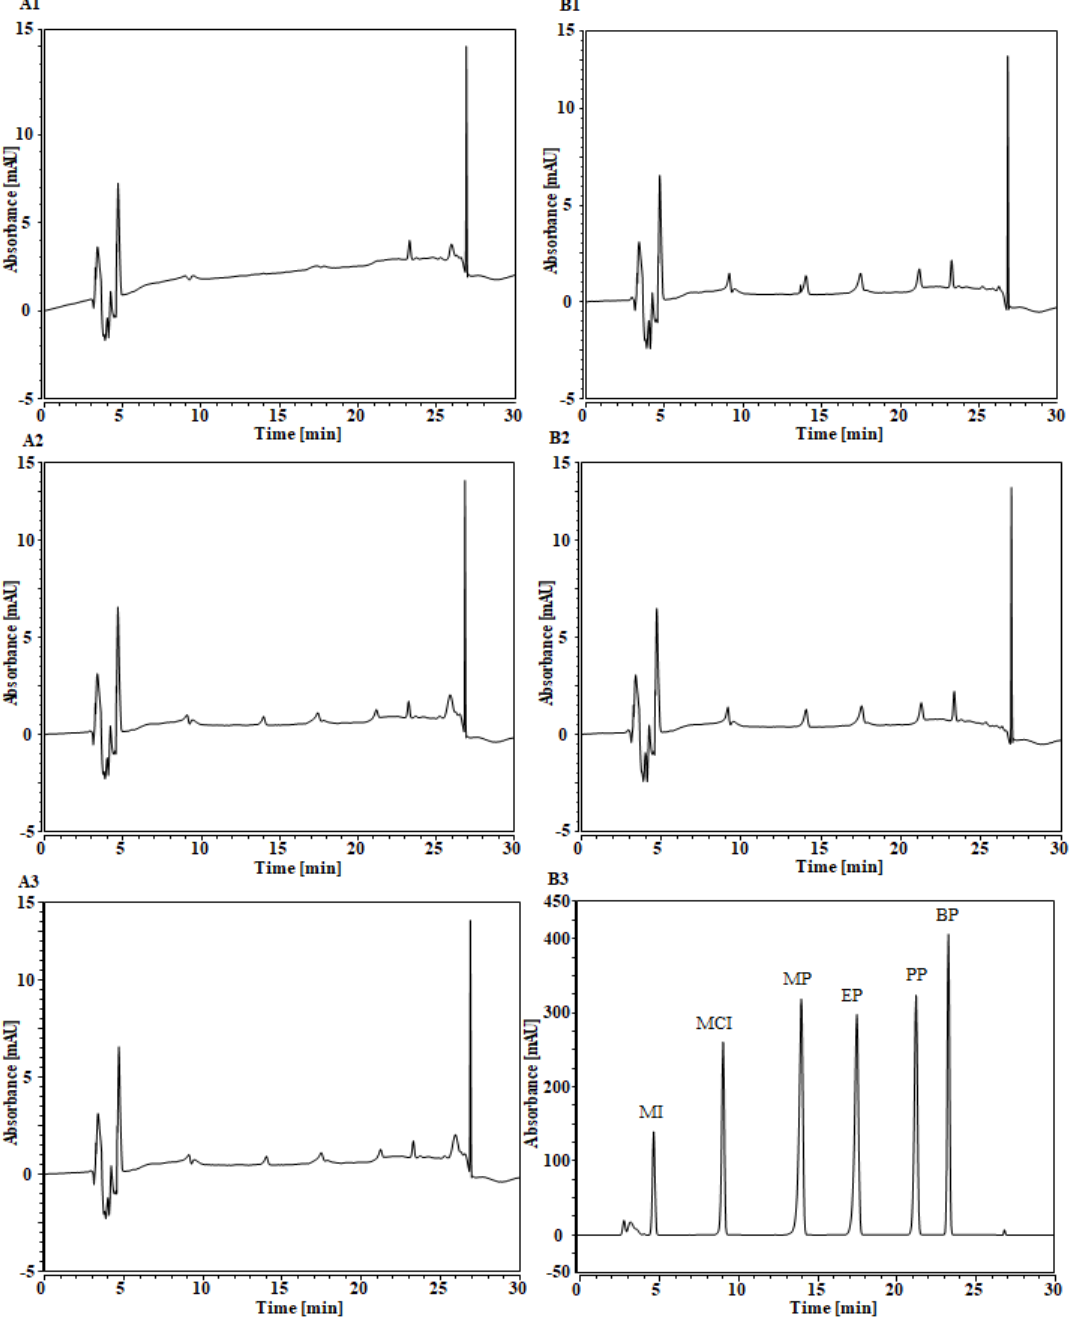
Figure 1. UHPLC / DAD chromatograms of studied compounds: ( A ) Sep-Pak C 18 and ( B ) HyperSep Figure 1. UHPLC/DAD chromatograms of studied compounds: ( A ) Sep-Pak C 18 and ( B ) HyperSep C 8 / BSAIE. (1) Water / methanol 2:1, v / v , (2) water / acetonitrile 2:1, v / v and (3) acetonitrile / methanol C 8 /BSAIE. (1) Water/methanol 2:1, v / v , (2) water/acetonitrile 2:1, v/v and (3) acetonitrile/methanol 2:1, 2:1, v / v v / v .